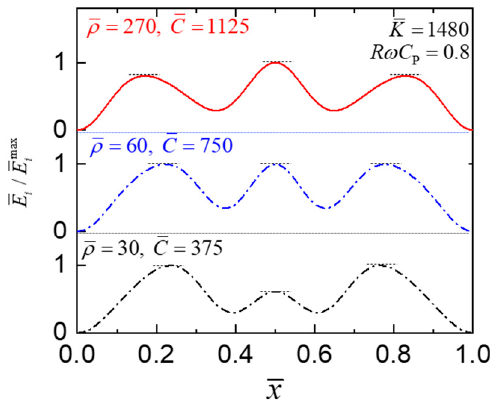
Figure 6. Influence of the normalized embedded position x of the piezoelectric energy harvester units on the normalized energy E .